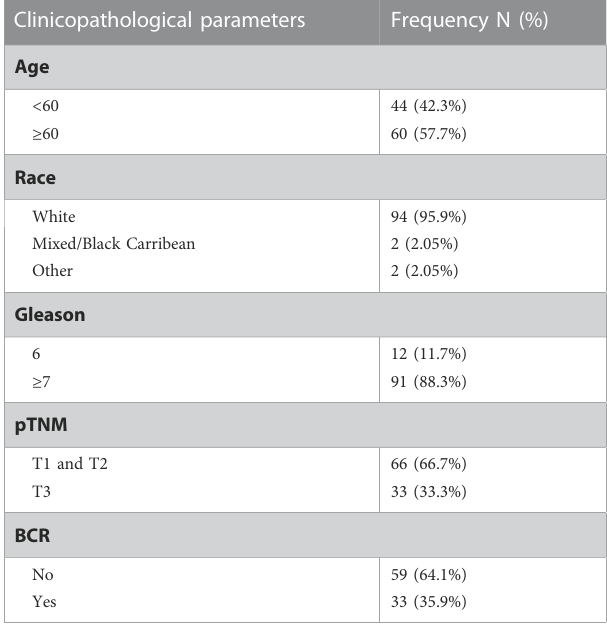
TABLE 1 Cohort 1 — Nottingham TMA clinical